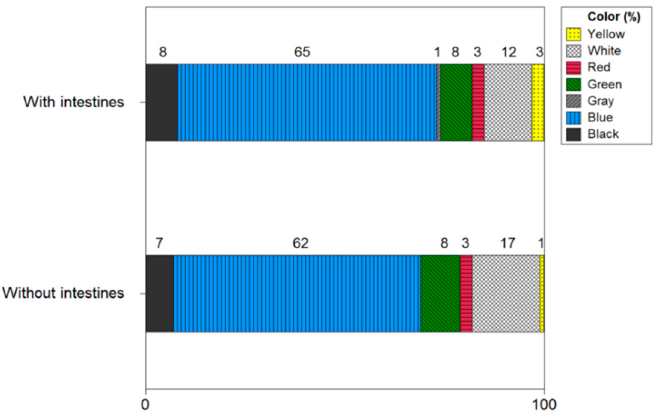
Figure 12. Color of microplastics with and without shrimp intestines and heads.